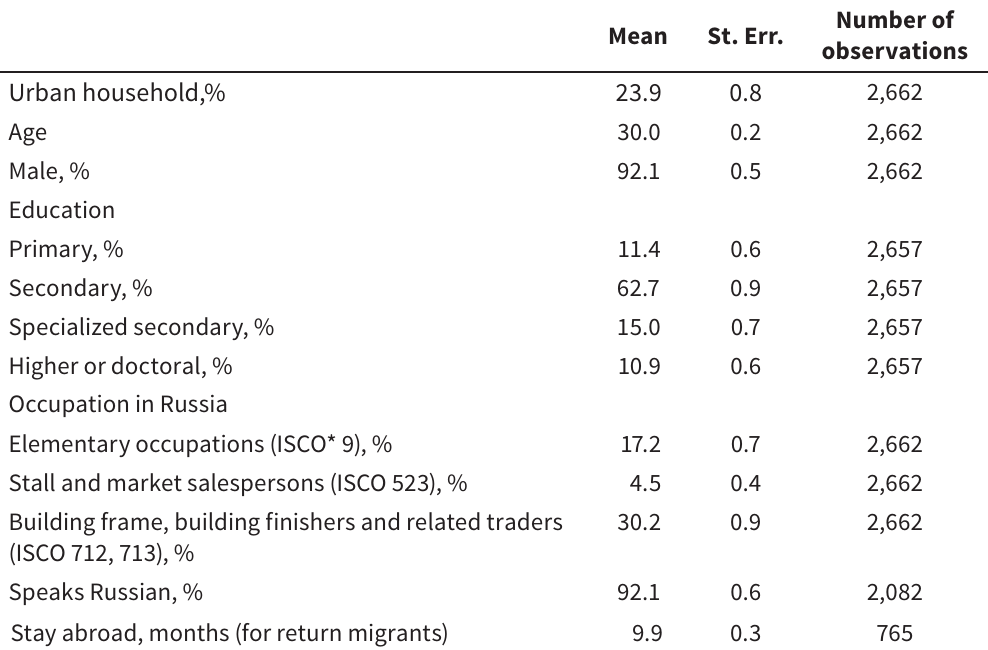
Migrant characteristics (2007, 2009, 2011)